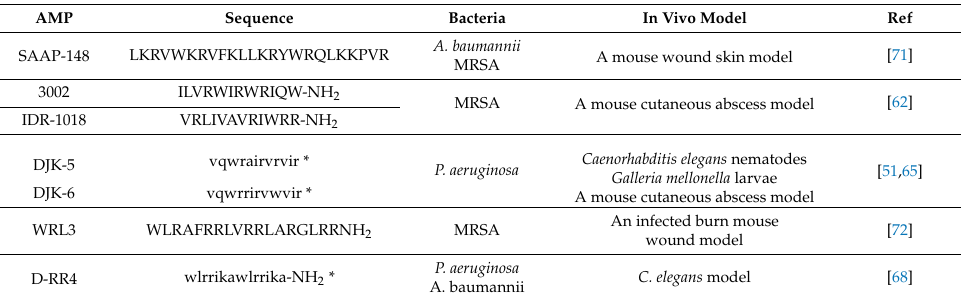
* Lower case letters represent D -amino